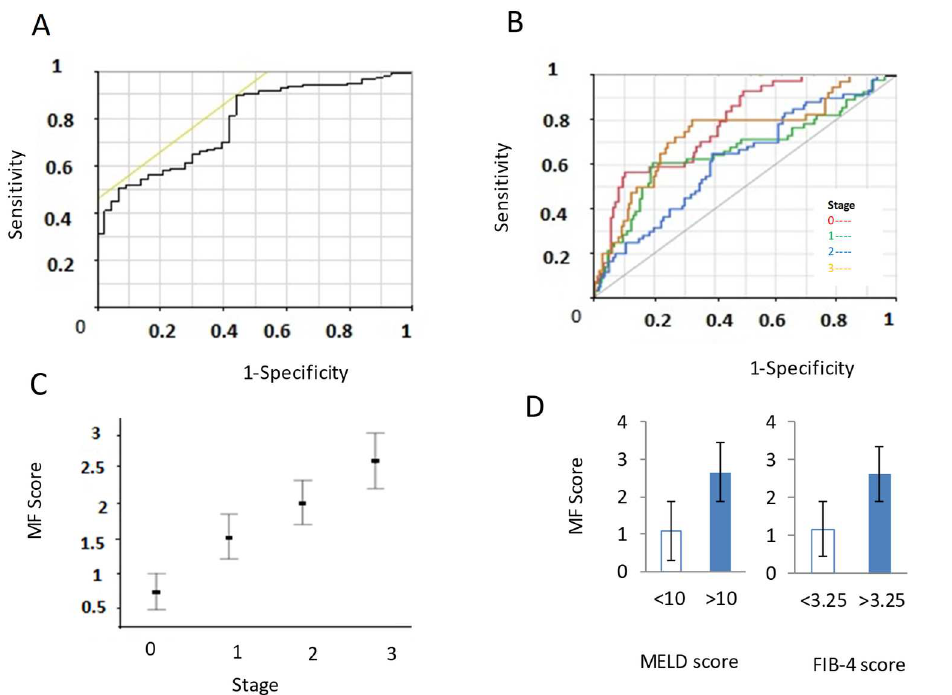
Fig 4. Performance of MF score . An MF score was derived using logistic regression analysis for the molecular feature (MF) with the highest area under a receiver operating characteristic curve (AUC). Receiver operator curves for the MF score for presence or absence of cirrhosis (A) or for the indicated cirrhosis disease stages (B). Variation in MF score at different disease stages (C), and with Model for End Stage Liver Disease (MELD) or FIB-4 scores (D). The data represent mean and SD of the MF score